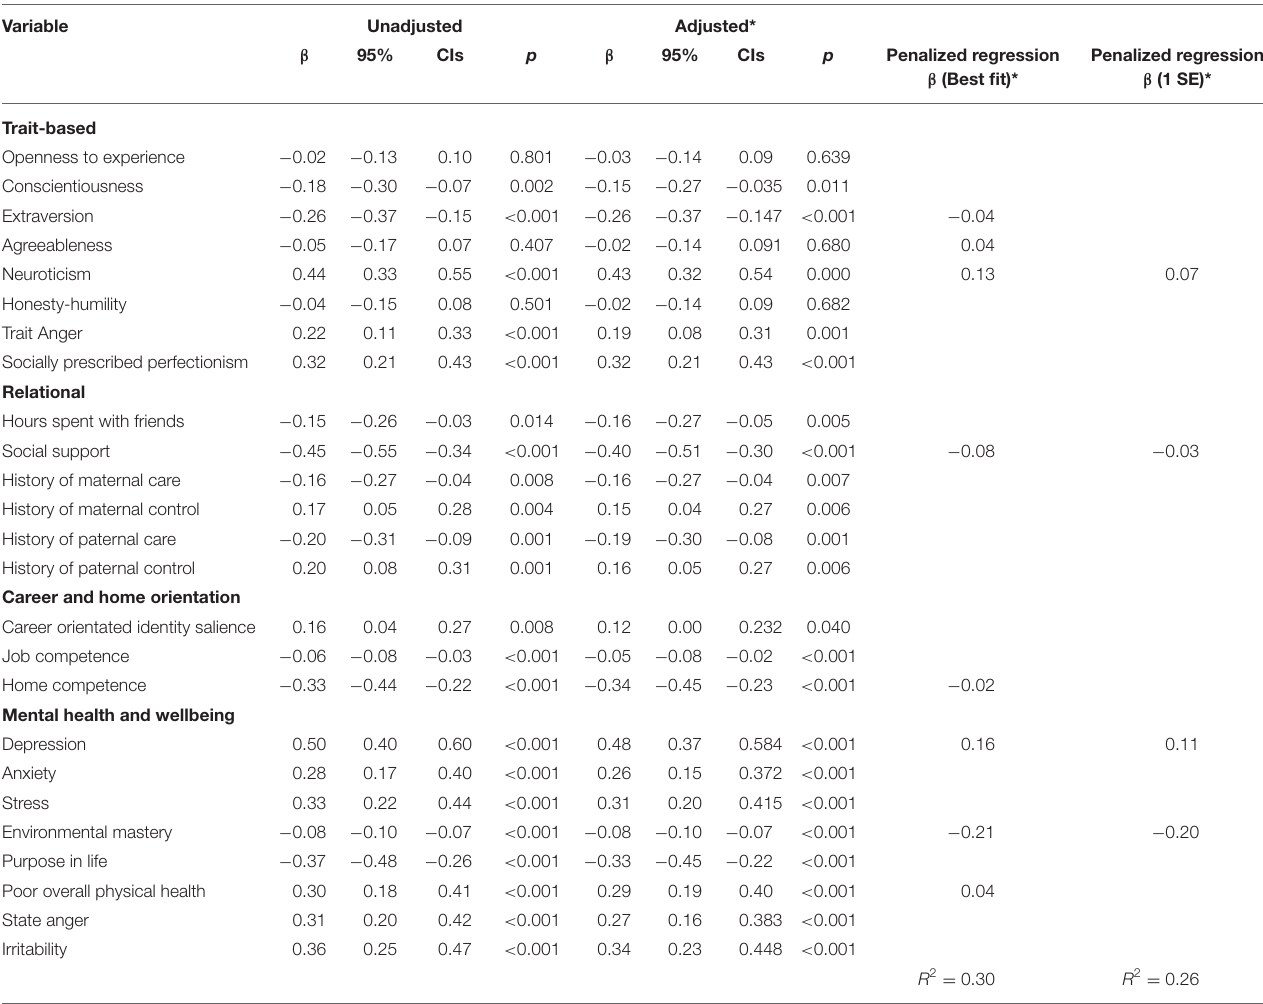
TABLE 3 | Associations between pre-pandemic predictors and subsequent pandemic loneliness. Variable Unadjusted Adjusted*